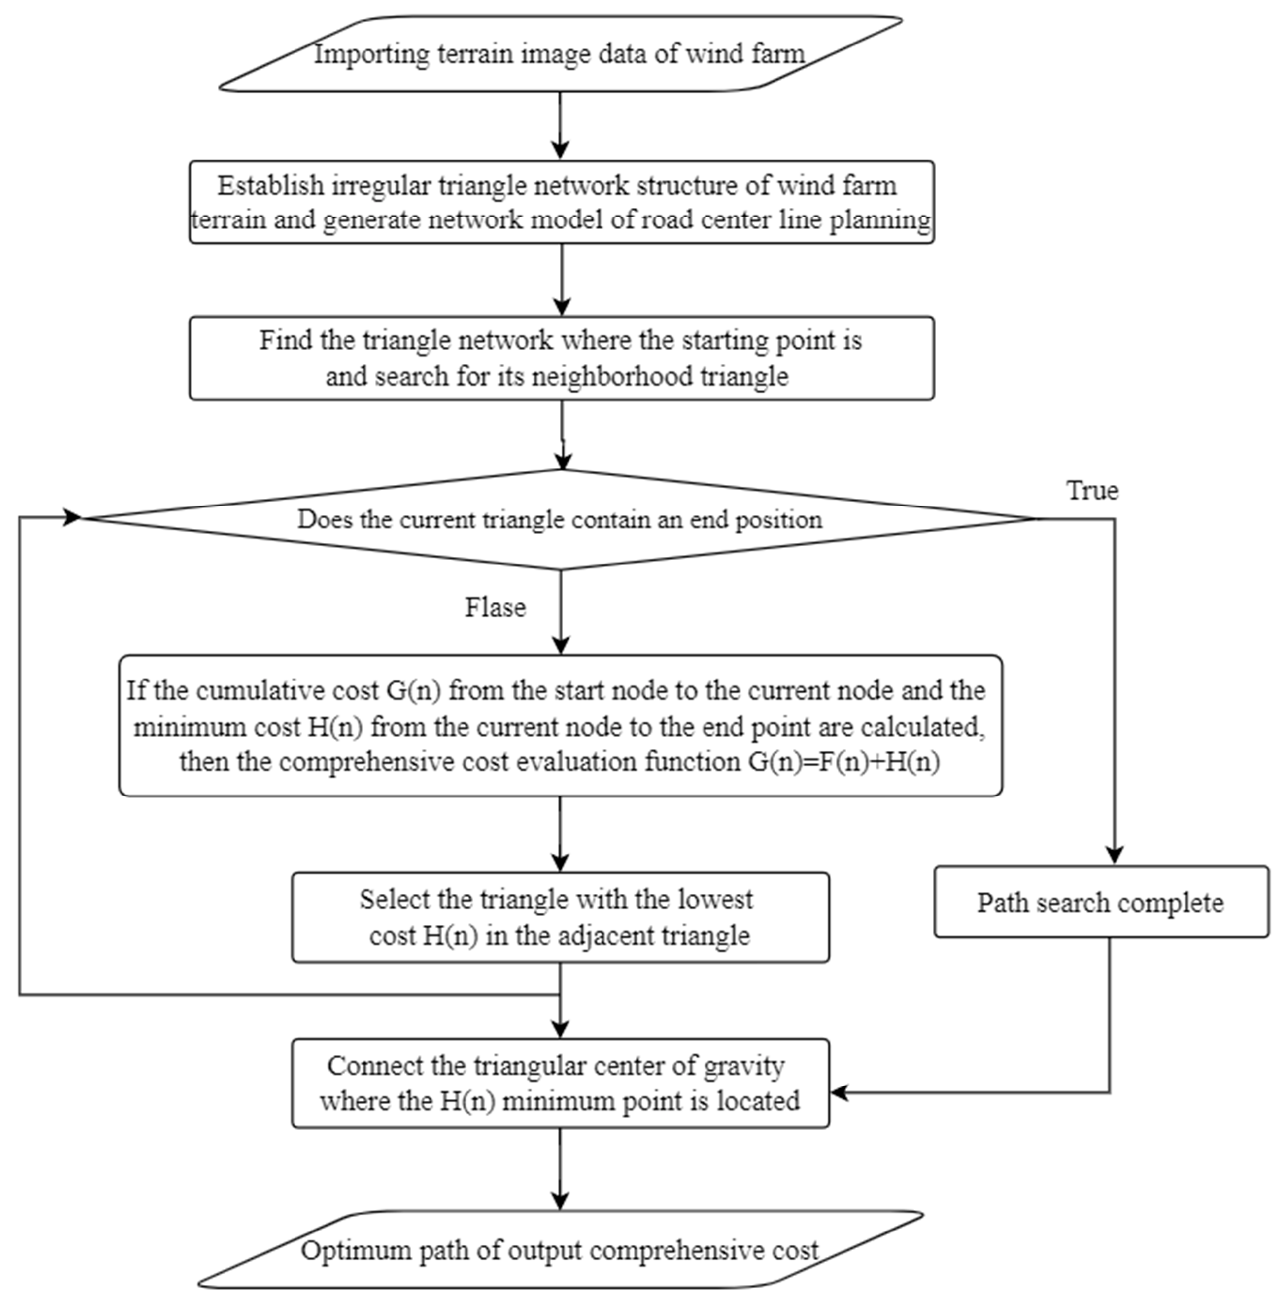
Figure 4. Algorithm